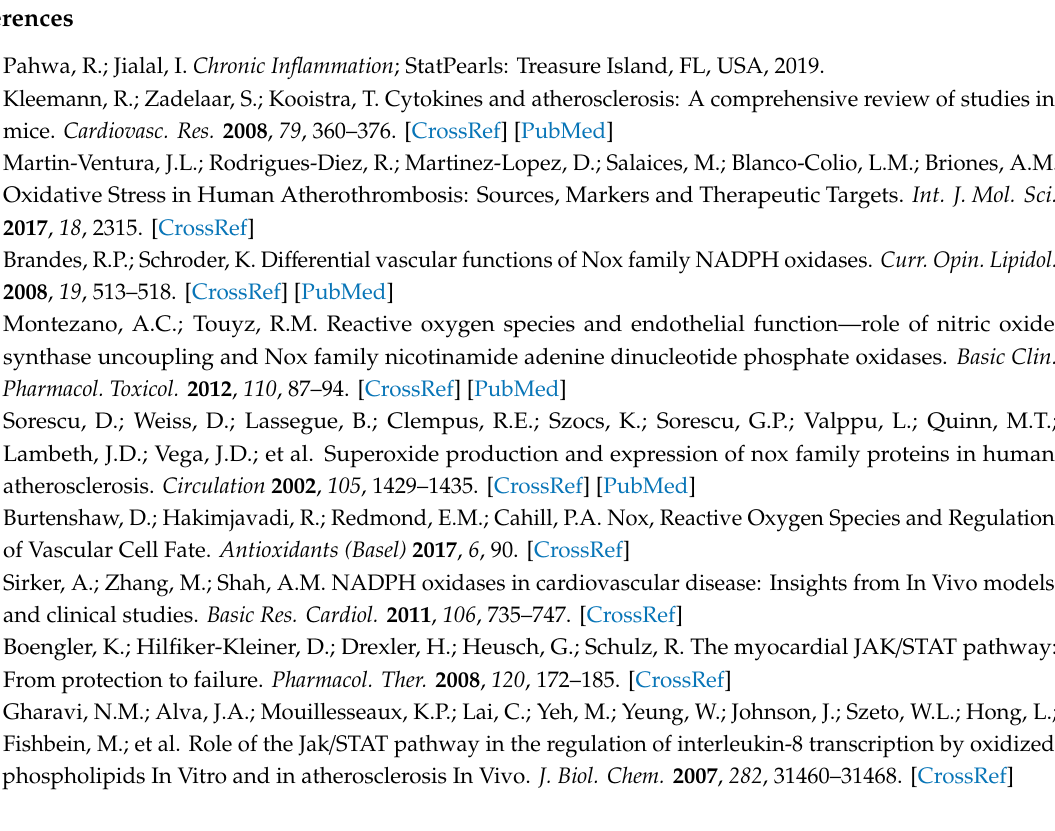
Figure S1: biodistribution of PS5 peptide in ApoE KO mice. Figure S2: biodistribution of PS5 peptide in ApoE KO mice. (a) In vivo and (b) ex vivo images showing tissue biodistribution of TAMRA-labeled PS5 peptide at 6 and 24 h postinjection. Abbreviations: H, heart; L, liver; S, spleen; K, Kidney. Microscopic distribution of PS5 in mouse atherosclerotic plaque at (c) 6 h and (d) 24 h postinjection. Red, TAMRA-PS5; blue, DAPI. Dashed line: plaque area; arrows: positive